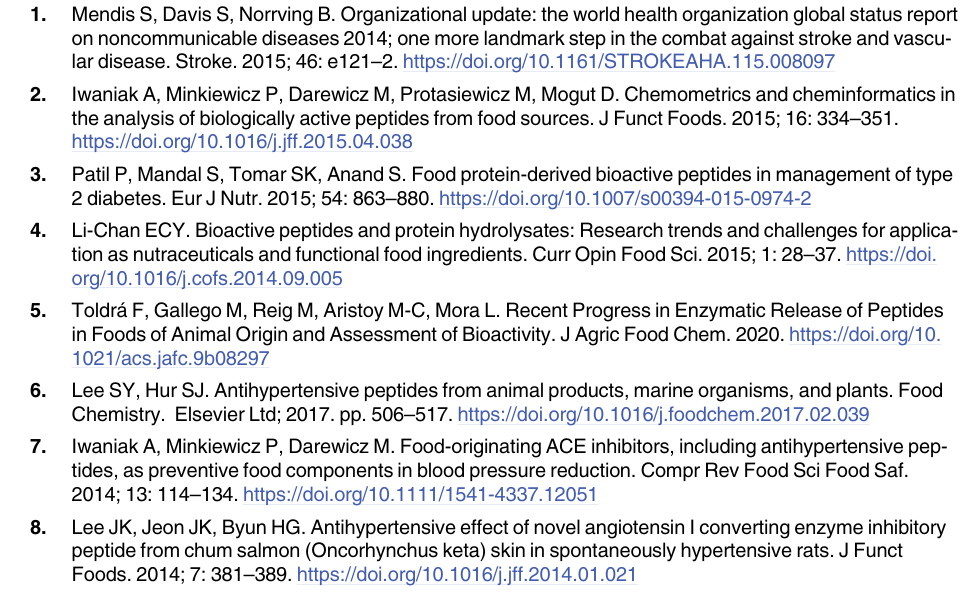
S6 Table. InChiKey and SMILES strings and structures of peptides with ionized acidic and basic groups released from the salmon and carp protein sequences after in silico simulated human-like